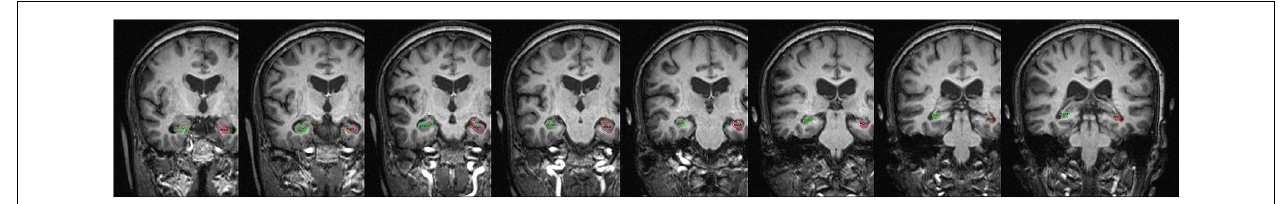
FIGURE 1 | Example images and representative analyses of hippocampal tracing rules from anterior to posterior brain sections . Marked structure on the right-hand side of the pictures represents